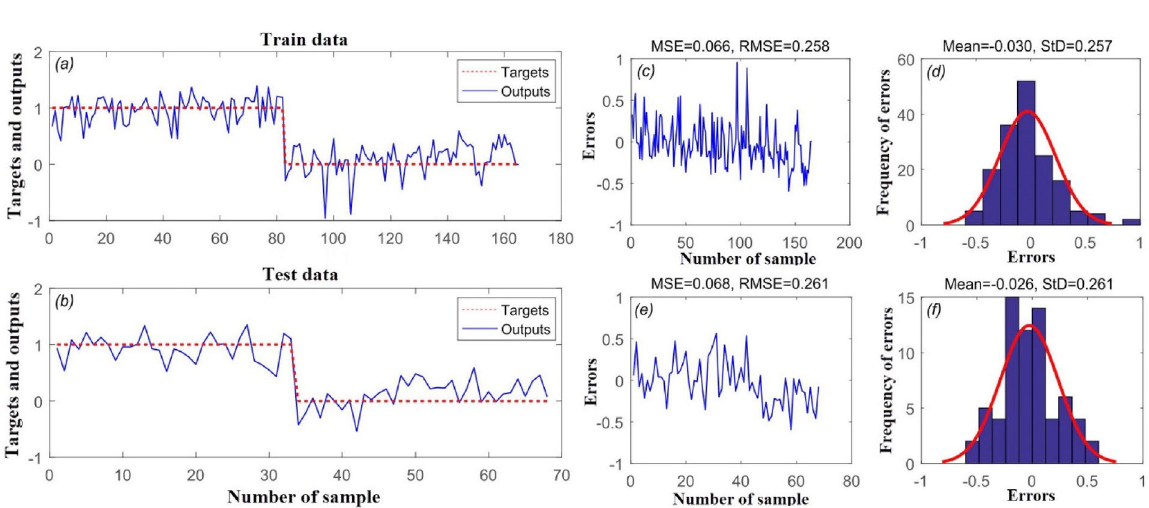
Figure 5. ( a ) Target and output Wavelet-SVR-BAT value of training data samples, ( b ) target and output Wavelet-SVR-BAT value of testing data samples, ( c ) mean squared error (MSE) and root mean square error (RMSE) of training data samples, ( d ) frequency of errors for training data samples, ( e ) MSE and RMSE value of testing data samples, and ( f ) frequency of errors for testing data